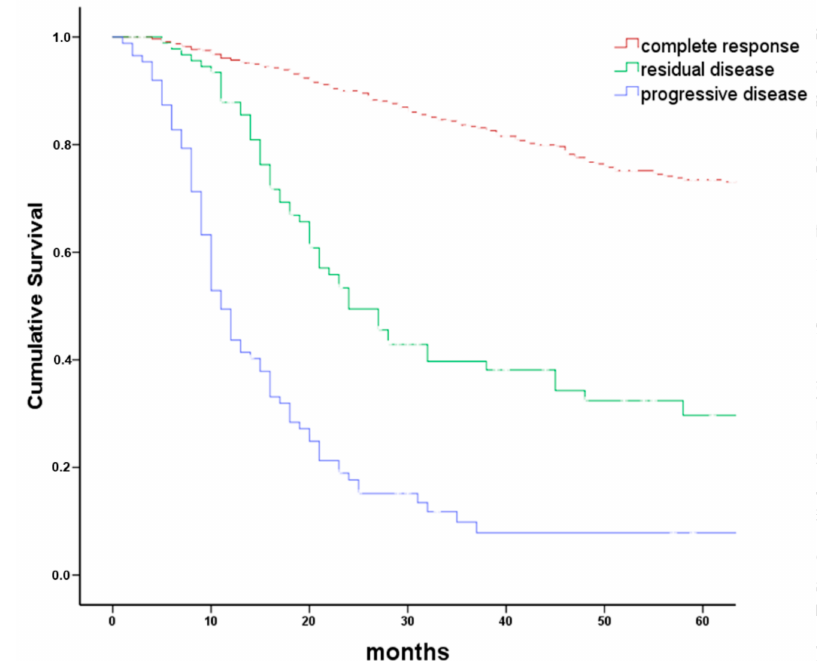
Figure 2. Overall survival grouped by tumor response to first-line therapy. Kaplan–Meier plot comparing overall survival in 741 patients with head and neck cancer grouped by response to first-line therapy. Treatment response was grouped in complete response (CR), residual disease (RD including partial response and no change), and tumor progression (PD). Logrank p < 0.001. Progressive disease was frequently associated with the new appearance of distant